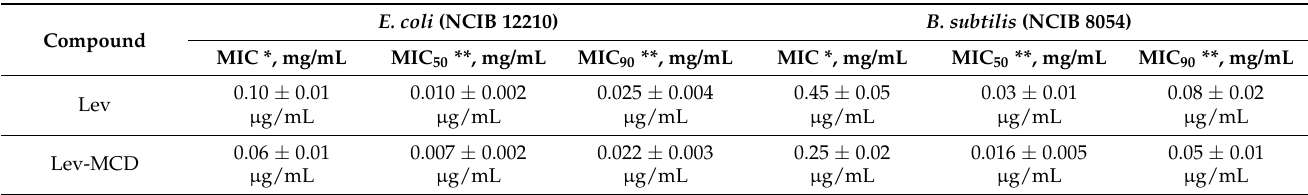
Table 3. Minimum inhibitory concentrations (MIC) of Lev, APAB and terpenoids X in the form of inclusion complexes with MCD. E. coli (5 × 10 6 CFU) and B. subtilis (7 × 10 6 CFU). LB medium (pH 7.2), 37 ◦ C, 20